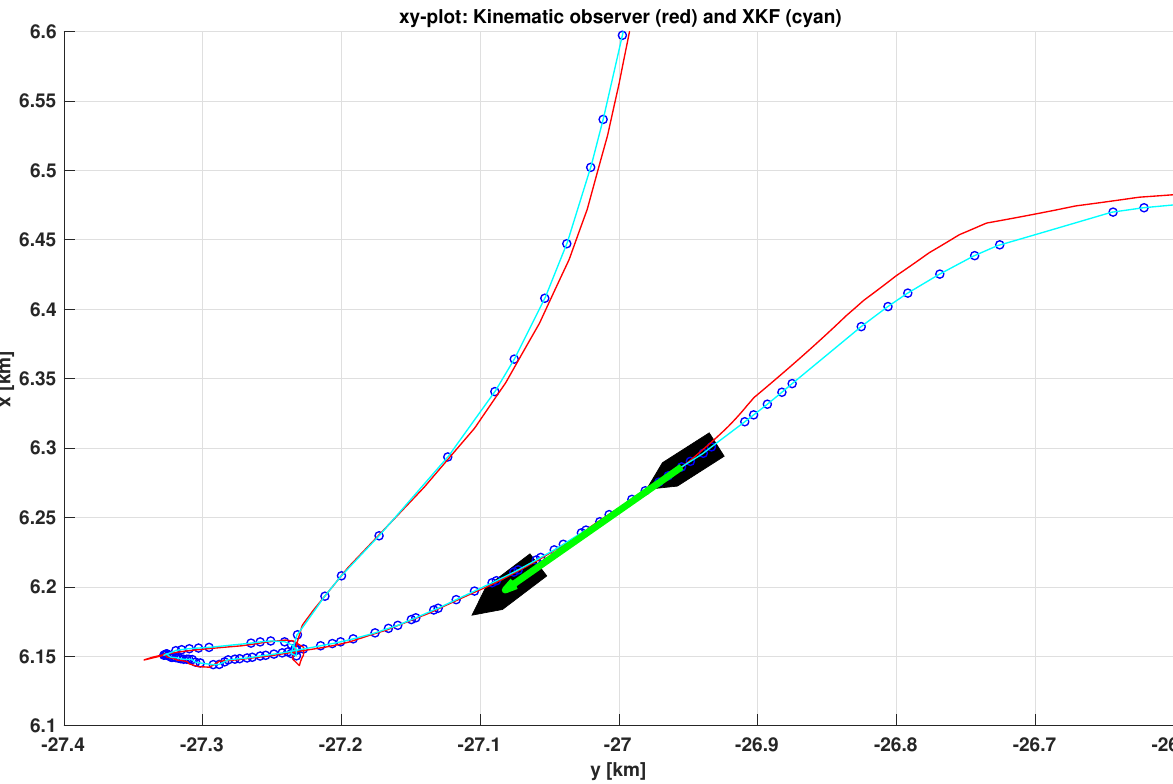
Figure 8: The 30 seconds predicted motion of MS LADEJARL just before the ship arrives Lensvik harbor. The red and cyan lines are the kinematic observer and XKF, respectively